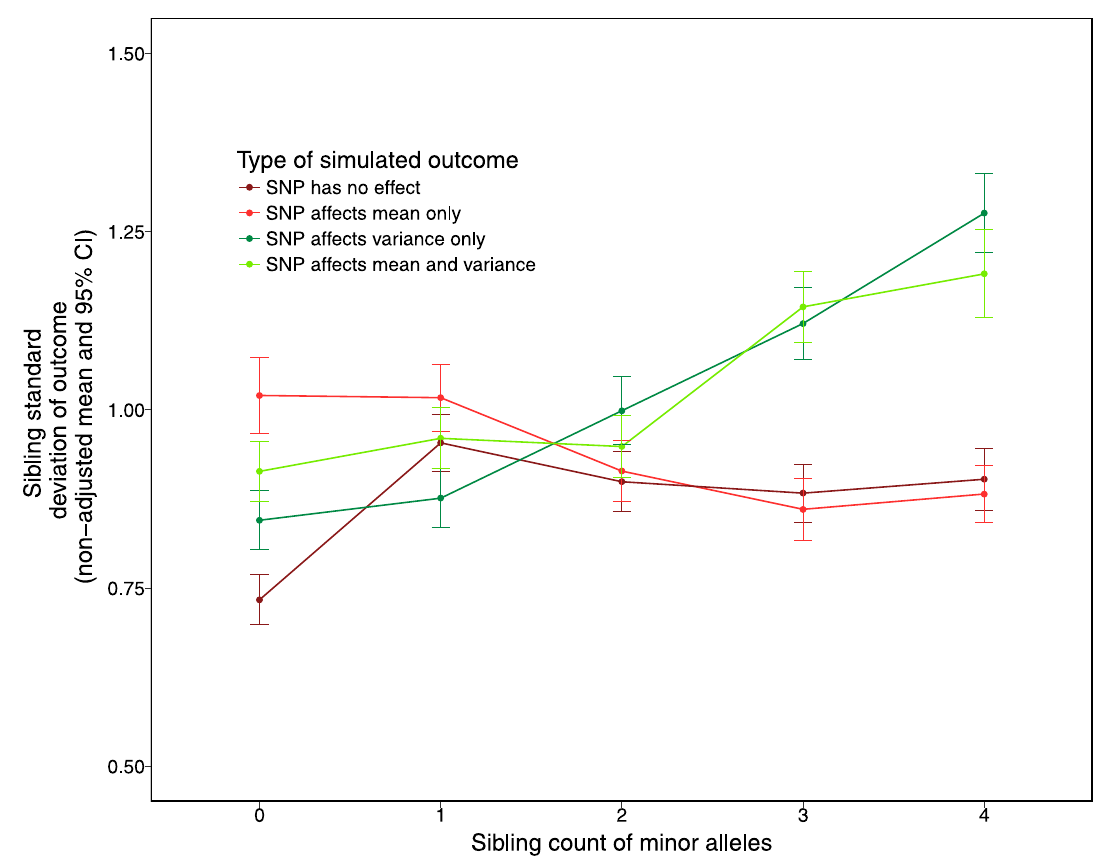
Fig 1. Raw means of sibling standard deviations (before age, sex, mean of trait, and parental genotype controls) by count of minor alleles. The graph shows that the sibling standard deviation increases with the count of minor allele snps that have effects on variance only, or effects on both the mean and variance of a trait, while stays flat for snp’s that only effect the mean or that not associated with the